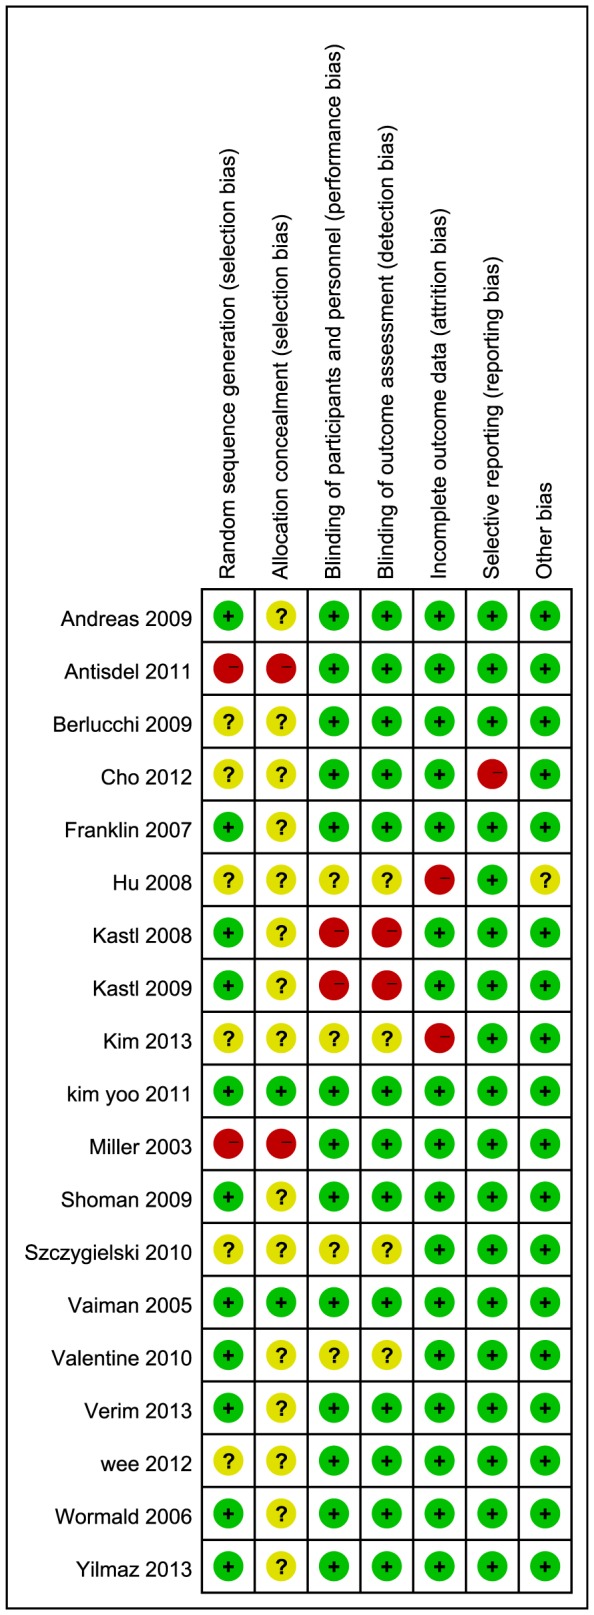
Risk of bias summary: review authors' judgments about each risk of bias item for each included study.